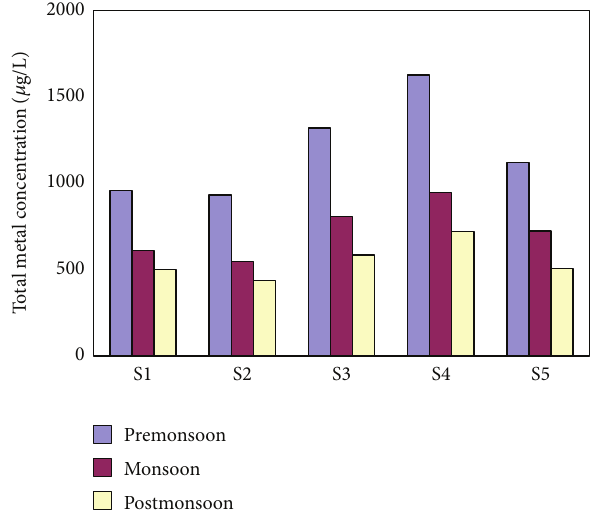
Figure 2: Total concentrations of trace metals at different sampling